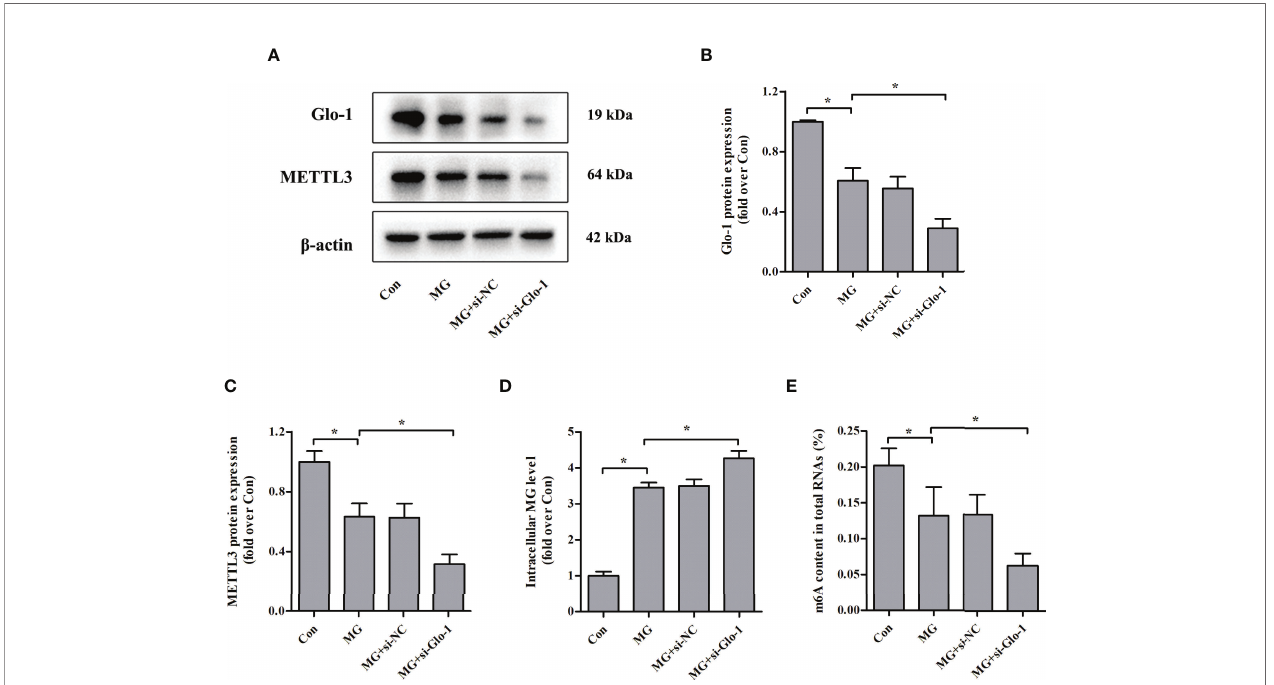
FIGURE 4 | Effects of Glo-1 knockdown on METTL3 expression and m 6 A RNA methylation levels in NIT-1 cells. (A – C) Immunoblotting of Glo-1 and METTL3 protein expression in NIT-1 cells transfected with Glo-1 (si-Glo-1) or a nonspeci fi c control siRNA (si-NC) and treated with 1 mM of MG for 24 h. (D) Intracellular MG levels in NIT-1 cells were treated as described in (A – C) . (E) m 6 A levels in total RNA from NIT-1 cells treated as described in (A – C) . Results are presented as the means ± SD of n = 3 – 4 independent experiments. * p <